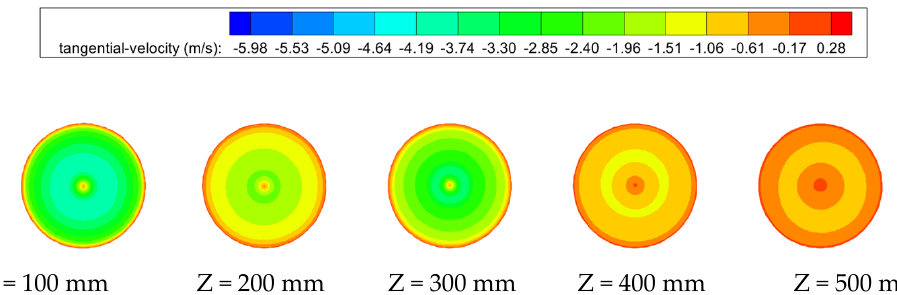
Figure 15. Tangential velocity distribution at different positions of inner cylinder of separator.